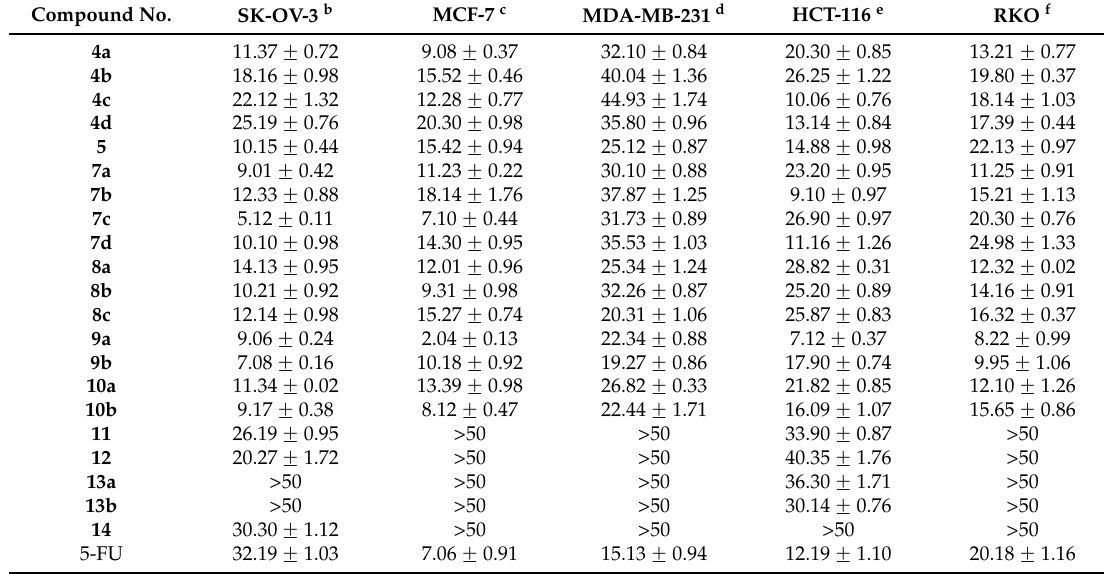
Table 1. IC 50 ( μ M) a of the synthesized 3-cyano-2-substituted pyridines against five cancer cell lines. Compound No.